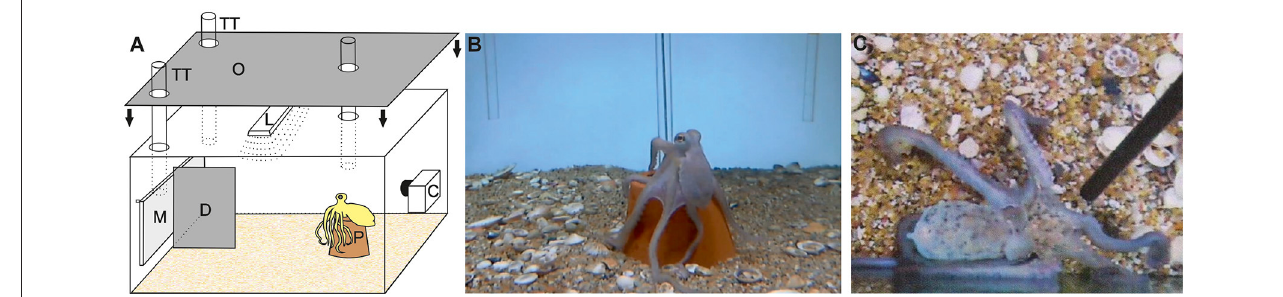
FIGURE 1 | Experimental setup. (A) A liquid crystal display (LCD) monitor M was attached to the tank from outside to signal the start and the end of each single trial by lighting and dimming the monitor, respectively. The area in front of the monitor was separated by a divider D into two compartments. In each compartment, a target tube TT was inserted through the lid of the aquarium; the animals were required to touch the target tube for a response. Each single trial started with the animal positioning itself on a flower pot P at approximately 50cm distance to the monitor. The whole area was illuminated by a lamp L. To avoid secondary cues during experiments, the top of the aquarium and the side walls were shielded with an opaque cover O (side cover not shown for clarity). Experiments were observed and recorded with the help of a camera C. Not drawn to scale. (B) Photograph of the camera with which the aquarium could be overseen even if the aquarium was covered from all sides. The octopus is sitting on the flower pot, and the two target tubes are on the left and right side in front of the monitor, which has already turned bright signaling the start of the trial. A third tube close to the flower pot served to lure the octopus to the flower pot, if necessary. Please note that the divider can hardly be seen due to the position of the camera with respect to it and as it is aligned with the third tube. (C) After an incorrect response, the octopus was presented with an incorrect choice signal (ICS), a black rod, upon which the octopus initially/sometimes changed their body pattern to a broad mottle pattern—the ICS was introduced when training stagnated (group 1) or right from the start of training (group